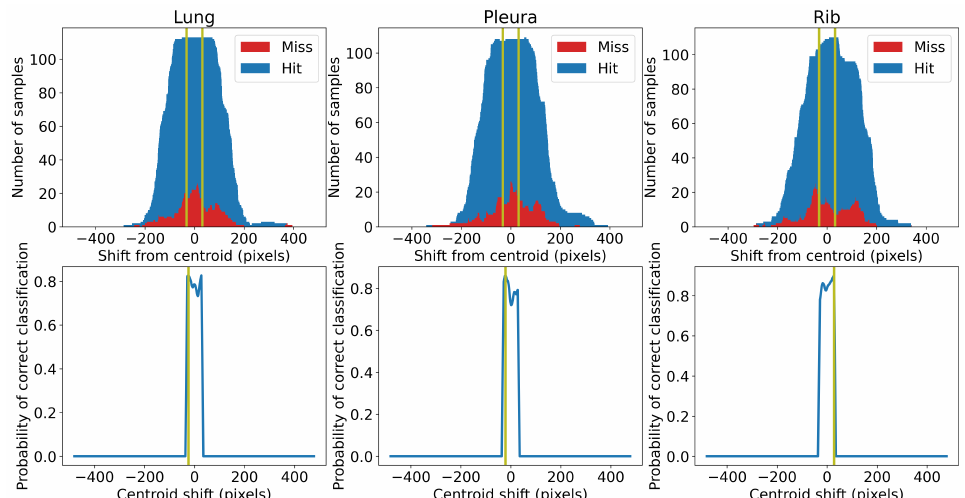
Figure 4. Centroid shifts calculated for the pleura, lung, and rib. Upper axis: The histogram represents number of correct and incorrect predictions of classifiers based on the distance from the centroids (Hit: Correct classification; Miss: Incorrect classification). The yellow vertical line depicts the range of a possible shift for the centroid. Lower axis: Probability of correct classification based on the distance from the centroids within selected range. The yellow line represents the resulting shift for the